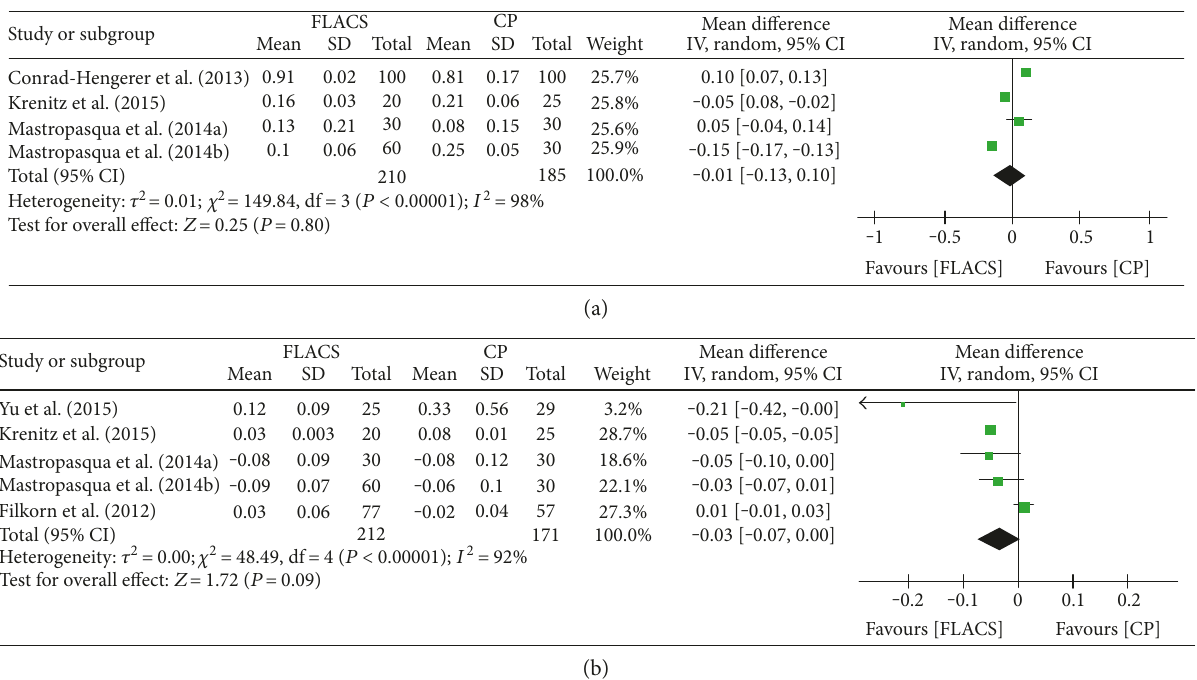
Test for overall effect: Z = 1.72 ( P = 0.09)